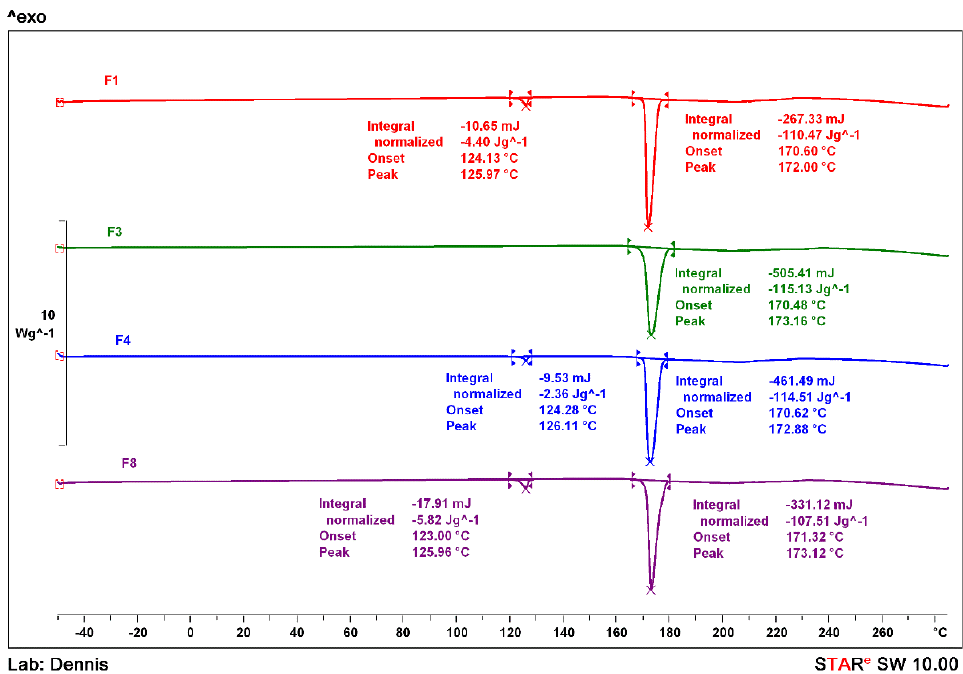
Figure 4. Differential scanning calorimetry (DSC) thermograms of bulk THL, bulk NIC and the THL-NIC physical mixture.